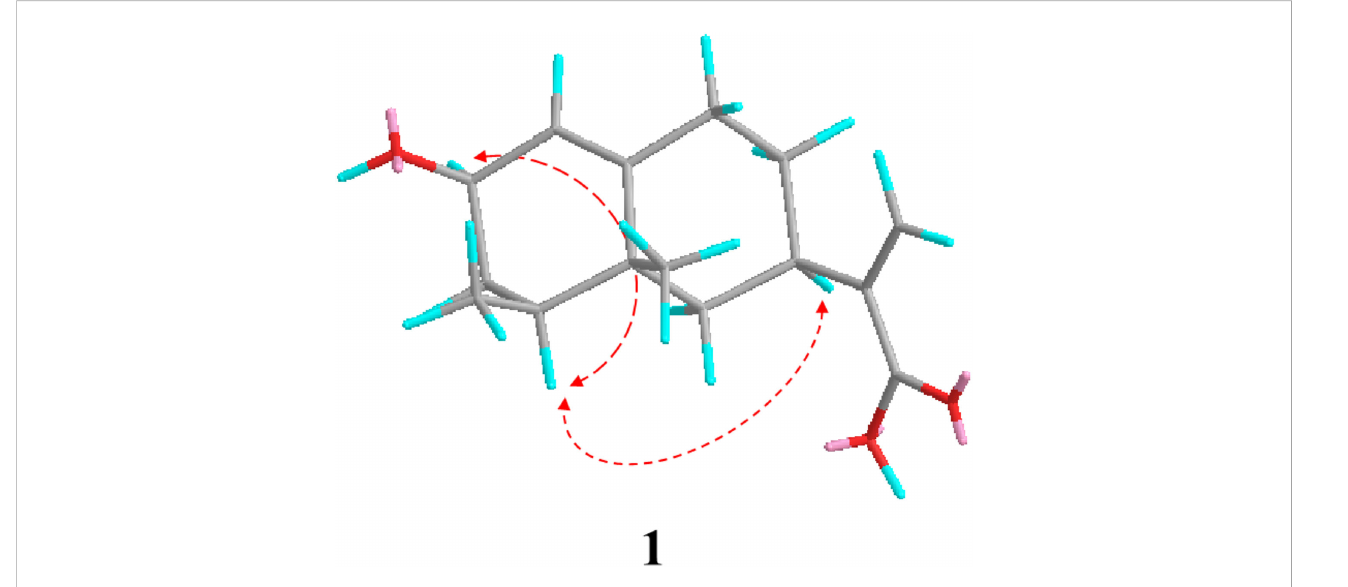
FIGURE 2 Key ROESY correlations of compound 1.